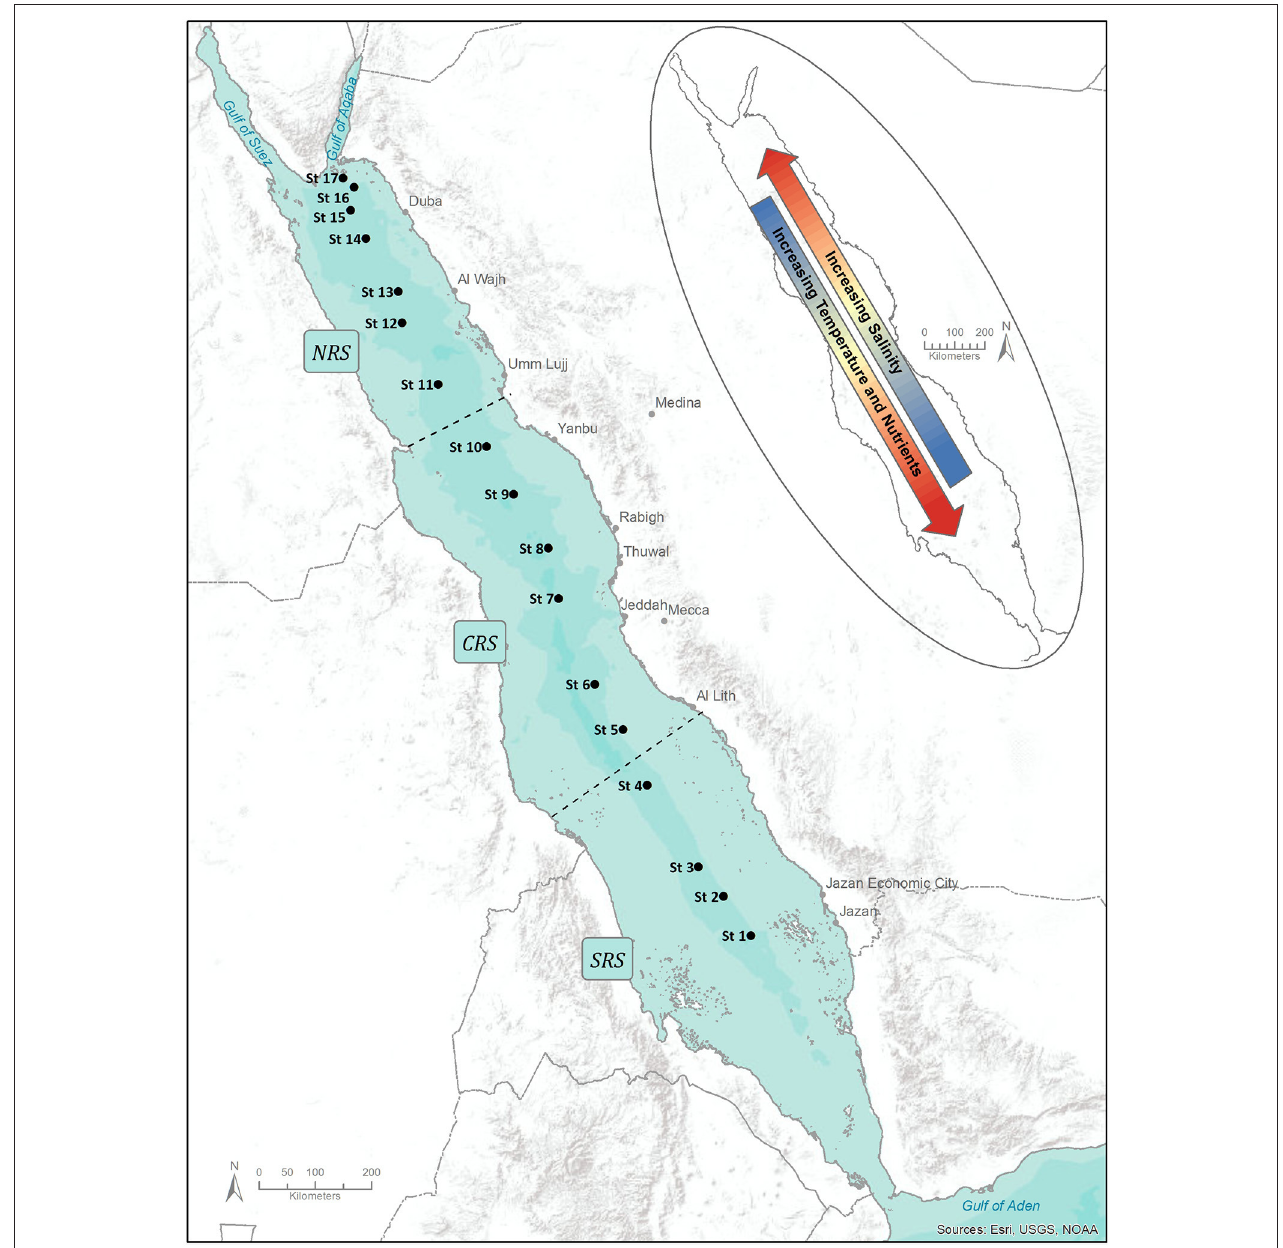
FIGURE 1 | Locations of stations sampled during the different cruises in the Red Sea between February and April 2015. The delineation of Northern Red Sea (NRS), the Central Red Sea (CRS) and the Southern Red Sea (SRS) is indicated on the map. The direction of latitudinal gradients in temperature, salinity and nutrients are illustrated. Map Produced using